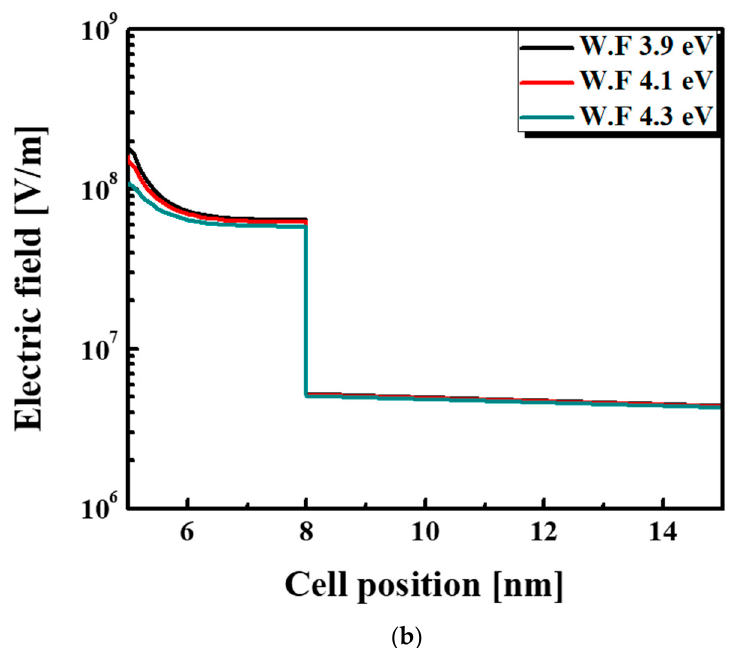
Figure 6. The ( a ) current density–voltage (J–V) and ( b ) electric field of the SHJ solar cells for various work functions of the LiF x as an electron selective layer.